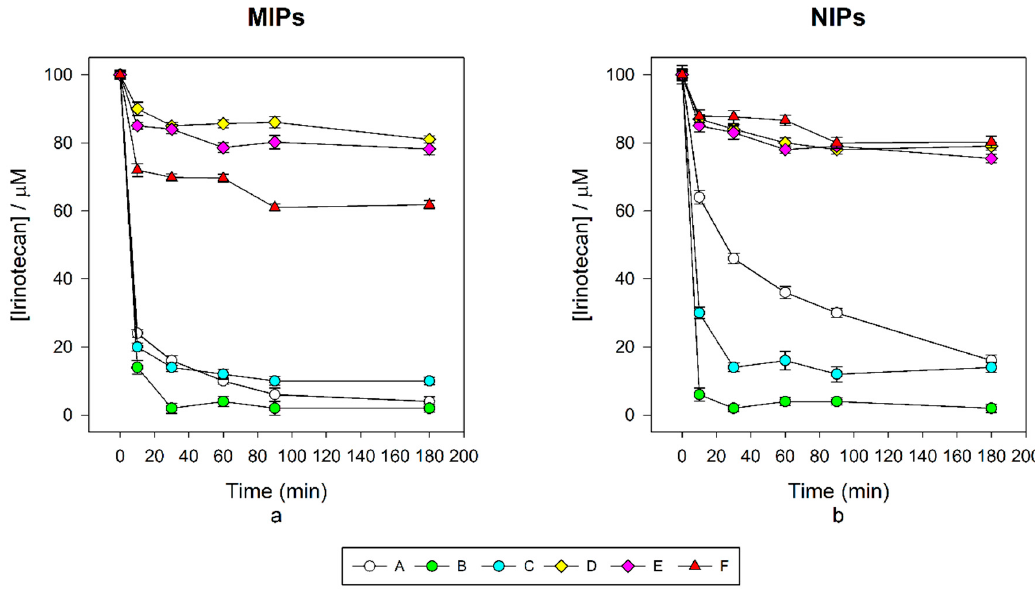
Figure 3. ( a ) Decay of irinotecan concentration in 100 μ M solutions in the presence the MIPs; ( b ) decay of irinotecan concentration in 100 μ M solutions in the presence of the NIPs.